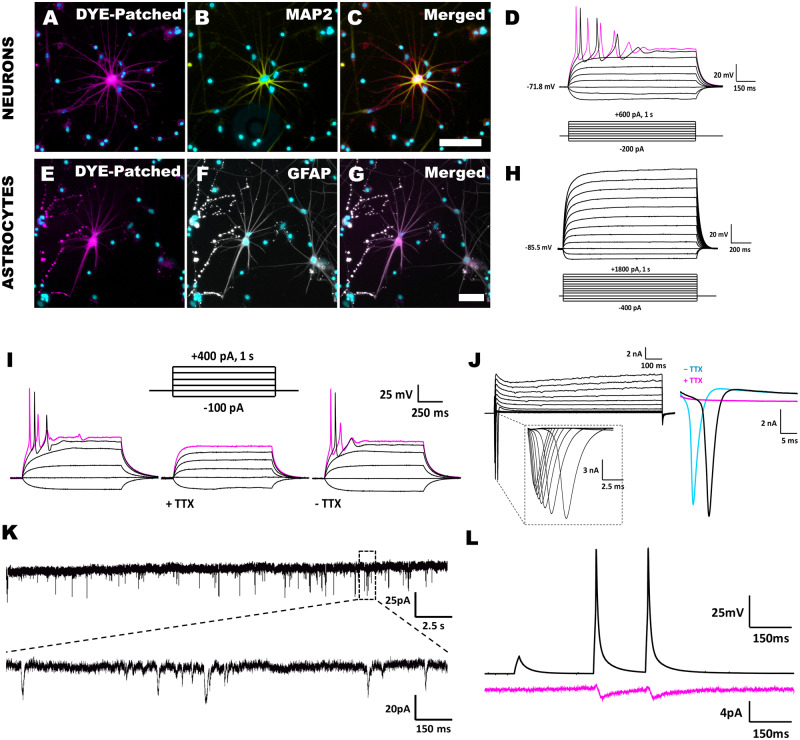

Photomicrographs and whole-cell patch-clamp recordings demonstrate the presence of electrophysiologically active neurons in our primary adult human brain cell cultures. A representative neuron injected with Alexa 568 dye during whole-cell patch-clamp recording (A) for post-recording analysis. This cell was found to express MAP2 (B, C) and fired repetitive-APs under current clamp with 1-s current pulses increasing in 100-pA increments from −200 pA (D; 23 DIV). A subset of cells did not fire APs in current-clamp recordings (H; 23 DIV). When dye-filled and analysed after whole-cell recording, this cell did not express MAP2 but did express GFAP (E–H). (I–L) Representative electrophysiological traces from whole-cell patch-clamped recordings (I; 28 DIV). Mature repetitive-APs that were blocked by the addition of tetrodotoxin (TTX; 1 µM). The APs reappeared upon TTX washout with artificial cerebral spinal fluid for 15 min (J; 28 DIV). A representative voltage-clamp trace showing the rapid and large inward current upon depolarization, which is again abolished in the presence of TTX and returned when TTX is washed out with artificial cerebral spinal fluid for 15 min. Voltage steps ranged from +10 to +120 mV in 10-mV increments (K; 14 DIV). Representative segment of spontaneous post-synaptic currents recorded in voltage clamp at −70 mV (L; 31 DIV). Representative traces from a paired whole-cell recording where post-synaptic currents were evoked in direct response to presynaptic APs, providing direct evidence of functional synaptic connections between adult human neurons in vitro. Scale: A–C and E–G = 100 µm